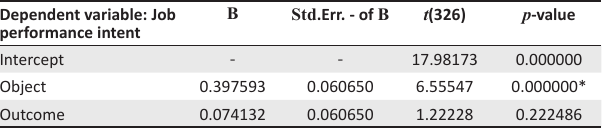
TABLE 8: The relationship between merger goal success, perceptions about merger outcomes and job performance intent. Dependent variable: Job performance intent